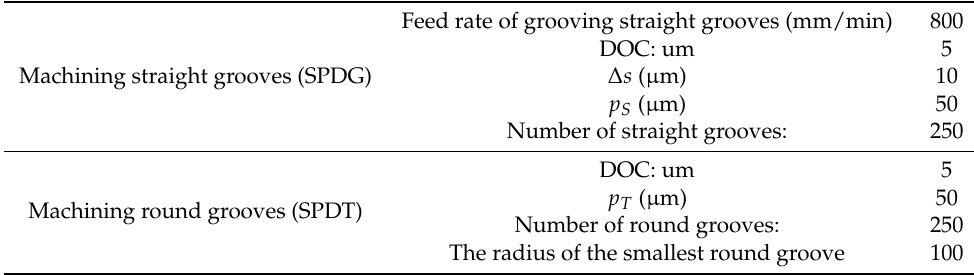
Table 1. Machining parameters for polar microstructures.